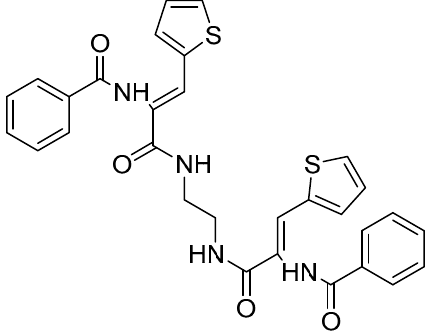
Figure 4. Suggested modifications – Compound 7.